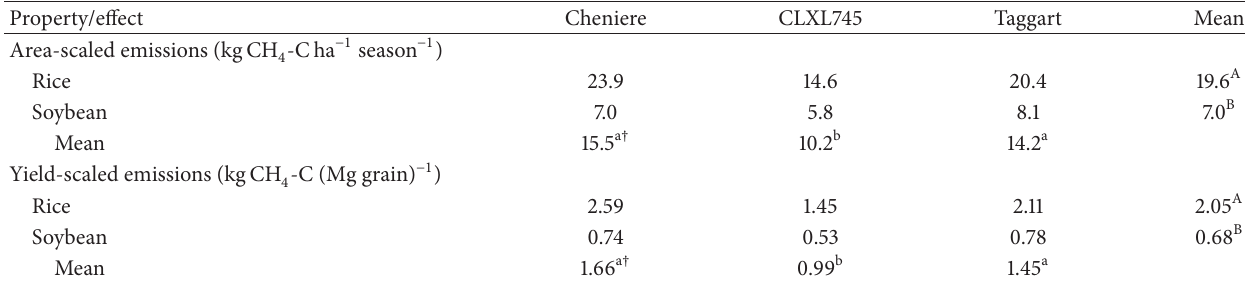
Table 5: Season-long methane (CH 4 ) emissions as affected by previous crop and rice cultivar expressed on an area- and yield-scaled basis from the 2013 growing season on a clay soil at the Northeast Research and Extension Center in Keiser,